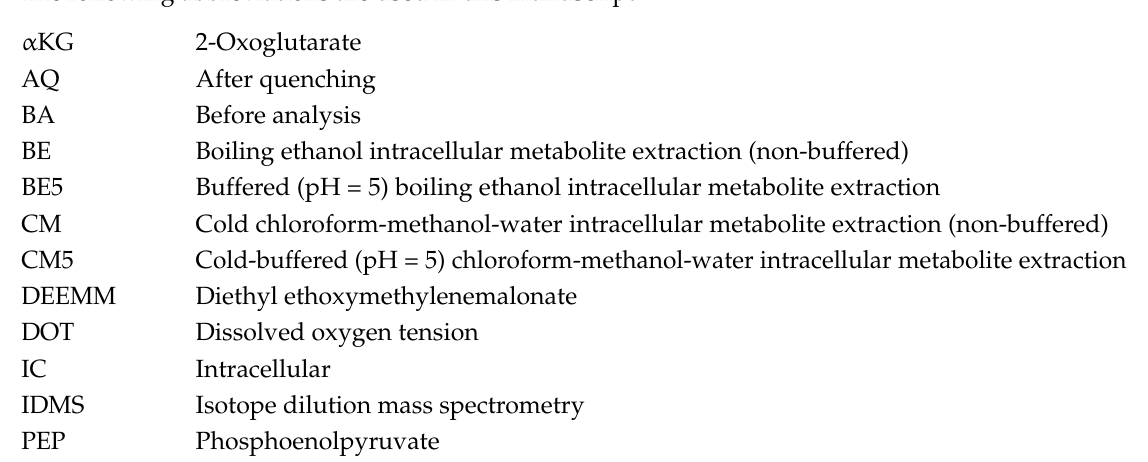
Table S1: Comparison between samples exposed to PVDF filters and samples not exposed to PVDF